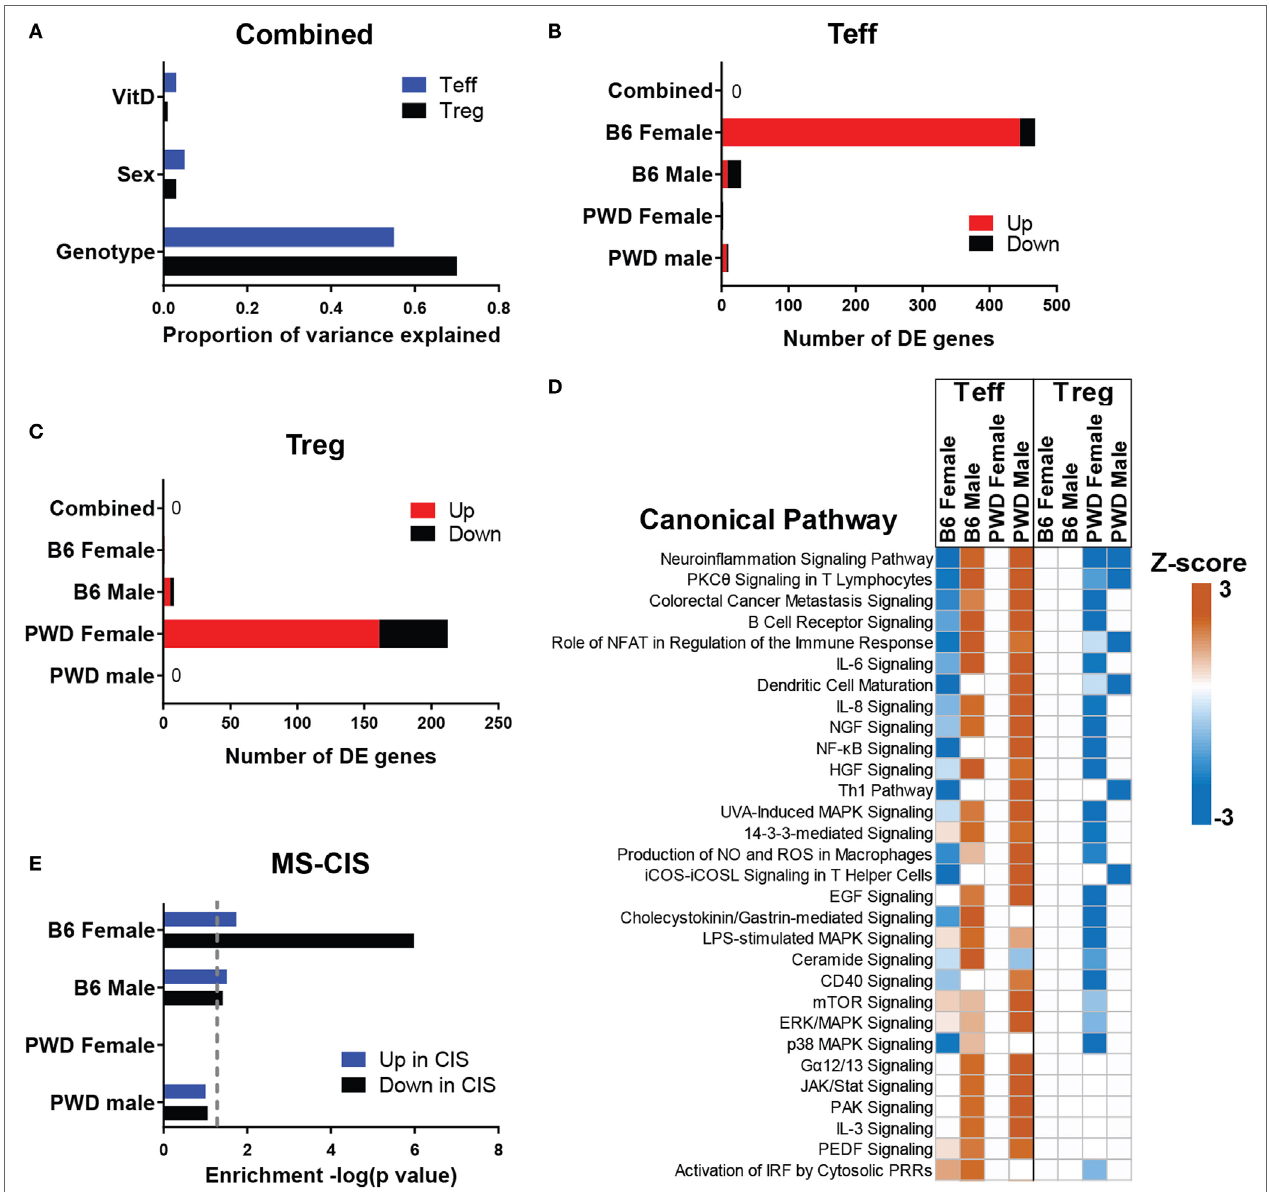
FigUre 3 | In vivo transcriptional regulation by vitamin D3 (VitD). Female and male B6 and PWD mice ( N = 4 for each sex/strain combination) were exposed to VitD-low and VitD-high diets as in Figure 1 . At 5 weeks post-dietary intervention, transcriptional profiling was performed on Teff and regulatory T cells (Tregs) as described in Section “Materials and Methods.” (a) The proportion of variance in gene expression explained by the indicated experimental variables is shown for Teff and Tregs. (B,c) The number of genes passing the differential expression threshold (|Fold Change| > 2, ANOVA p < 0.001) as a function of diet is shown for the indicated groups, in Teff (B) and Tregs (c) . Direction of change is depicted as expression level in VitD-high relative to VitD-low (e.g., “up” indicates higher expression in the VitD-high group). (D) Canonical pathway analysis was performed using IPA software (see Materials and Methods). Z -scores indicate predicted direction and relative strength of change (VitD-high relative to VitD-low). The top 30 pathways (ranked by Z -score) are shown. (e) Enrichment analysis of the indicated differentially expressed (DE) gene sets from Teff within transcripts DE (up or down) in CD4 cells from multiple sclerosis (MS)-CIS patients was performed using IPA (see Materials and Methods). p -Values for enrichment are shown as − log( p ). Dotted line denotes p = 0.05.